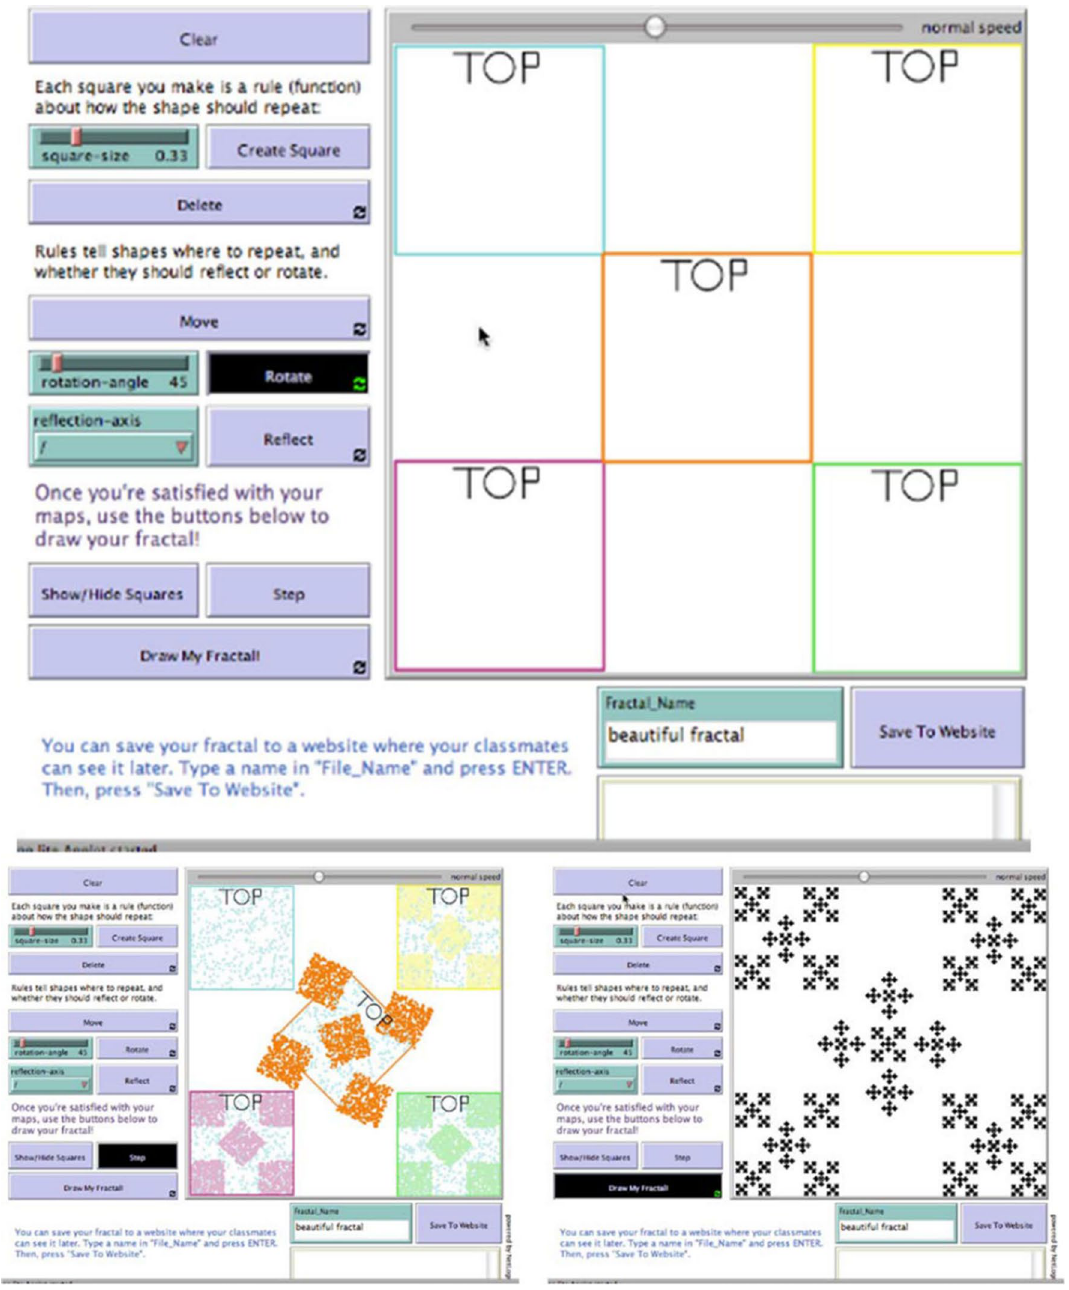
Fig. 8 Fractal construction interface and resulting computational objects (Wilkerson‑Jerde, 2014, p.